Question: Looking at the figure, what chart type is it?
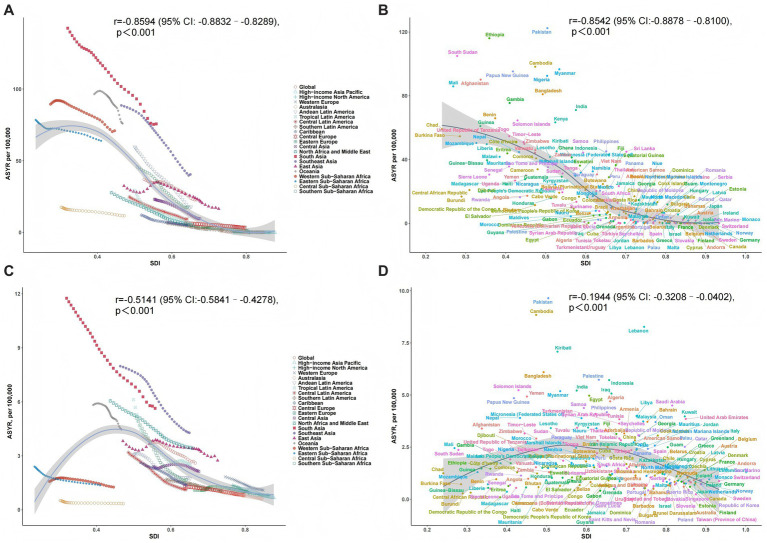
Answer: line